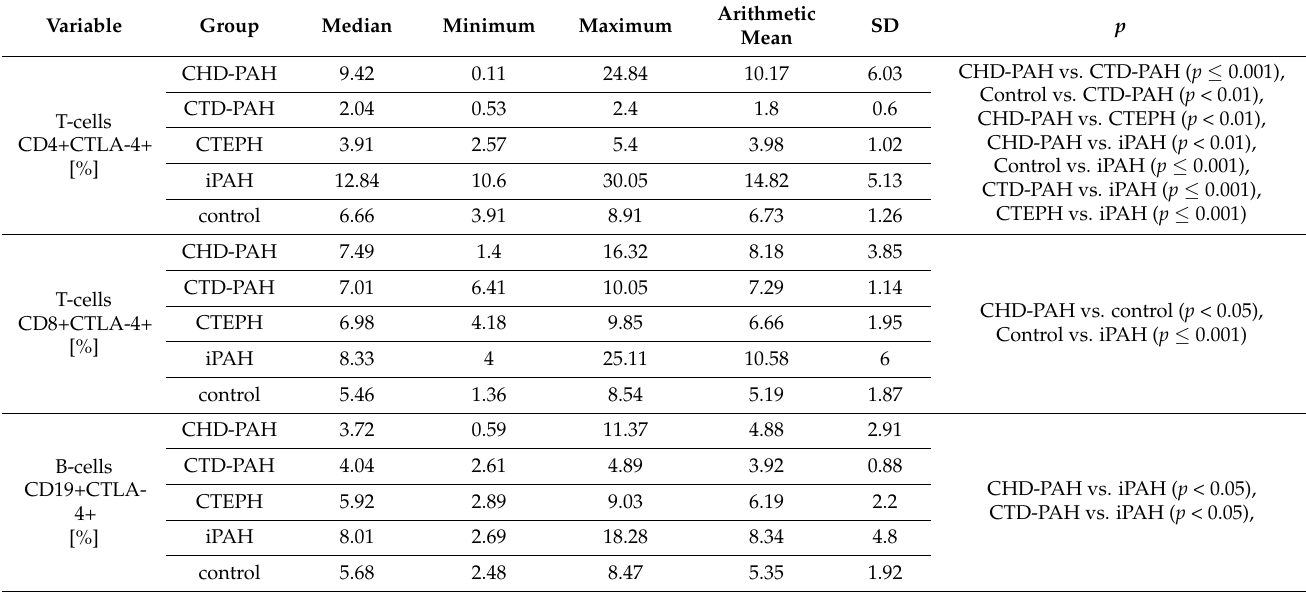
Table 1. Evaluation of the percentage of CTLA-4 molecule in CHD-PAH, CTD-PAH, CTEPH and iPAH patients and controls.